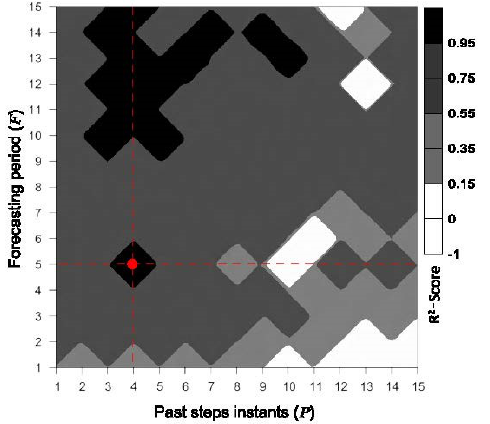
Figure 4. Median performance in terms of R 2 -Scores for different configurations of past steps instants and forecasting period parameters. The red dot indicates the best performance